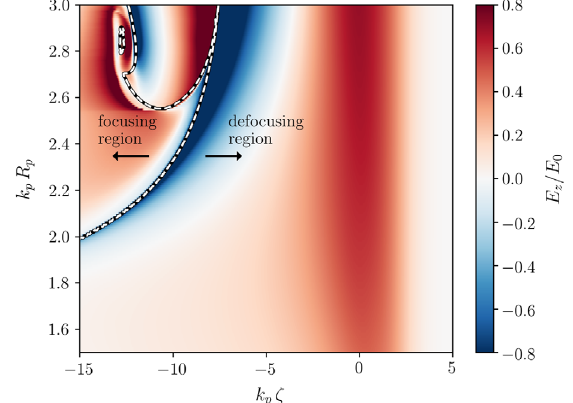
FIG. 3. On-axis longitudinal line-out of the accelerating field, E =E z 0 , plotted as a function of the plasma column radius, Red regions are accelerating for positrons. The separation between focusing and defocusing regions for positrons is marked with a dashed line.